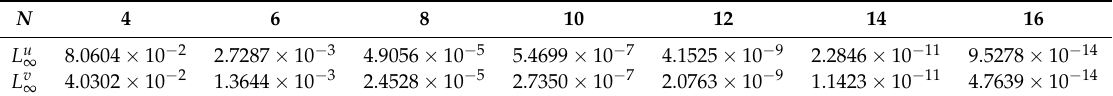
Table 4. The maximal absolute errors L u ∞ and L v ∞ for Example